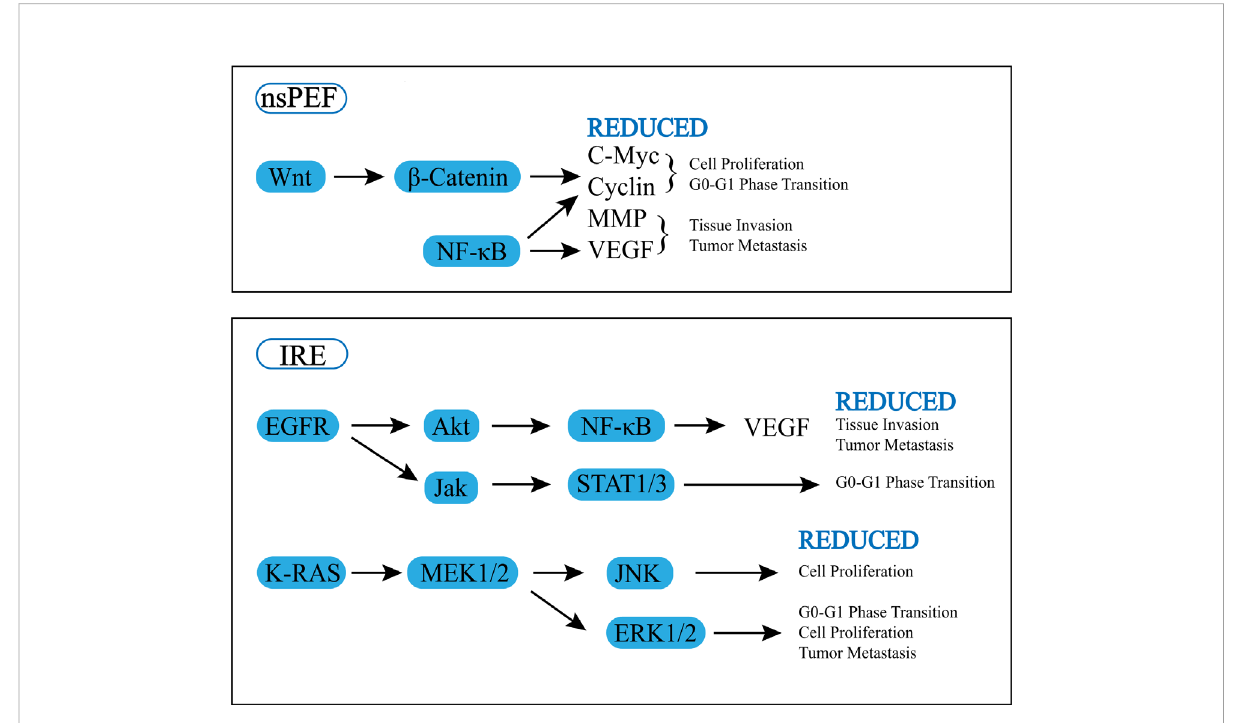
FIGURE 1 Effect of pulsed fi eld ablation on cell signal